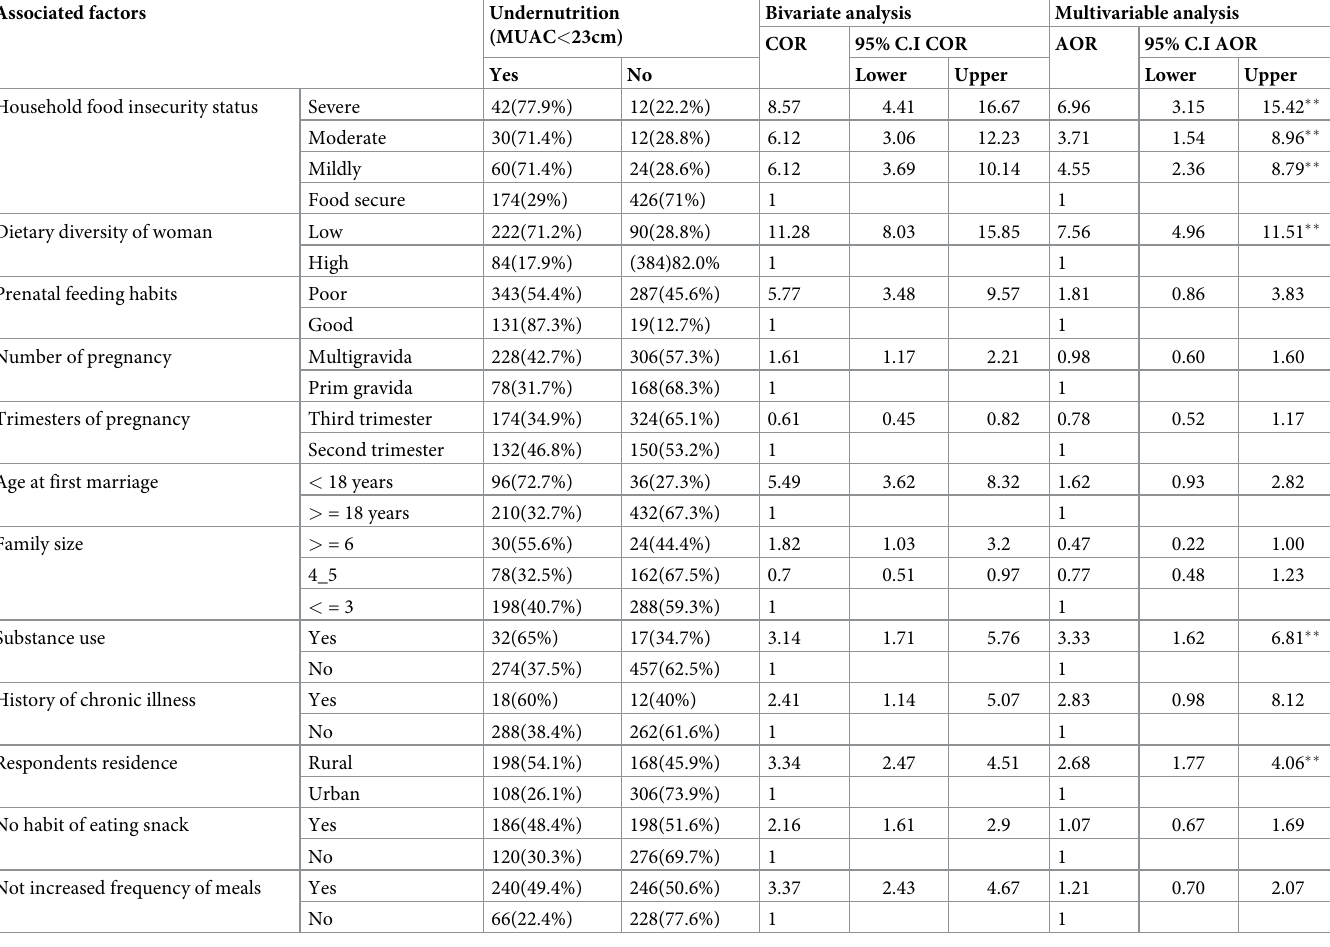
Table 8. Multivariate analysis of factors associated with under nutrition among pregnant women attending ANC services at public hospitals of West Wollega Zone. Associated